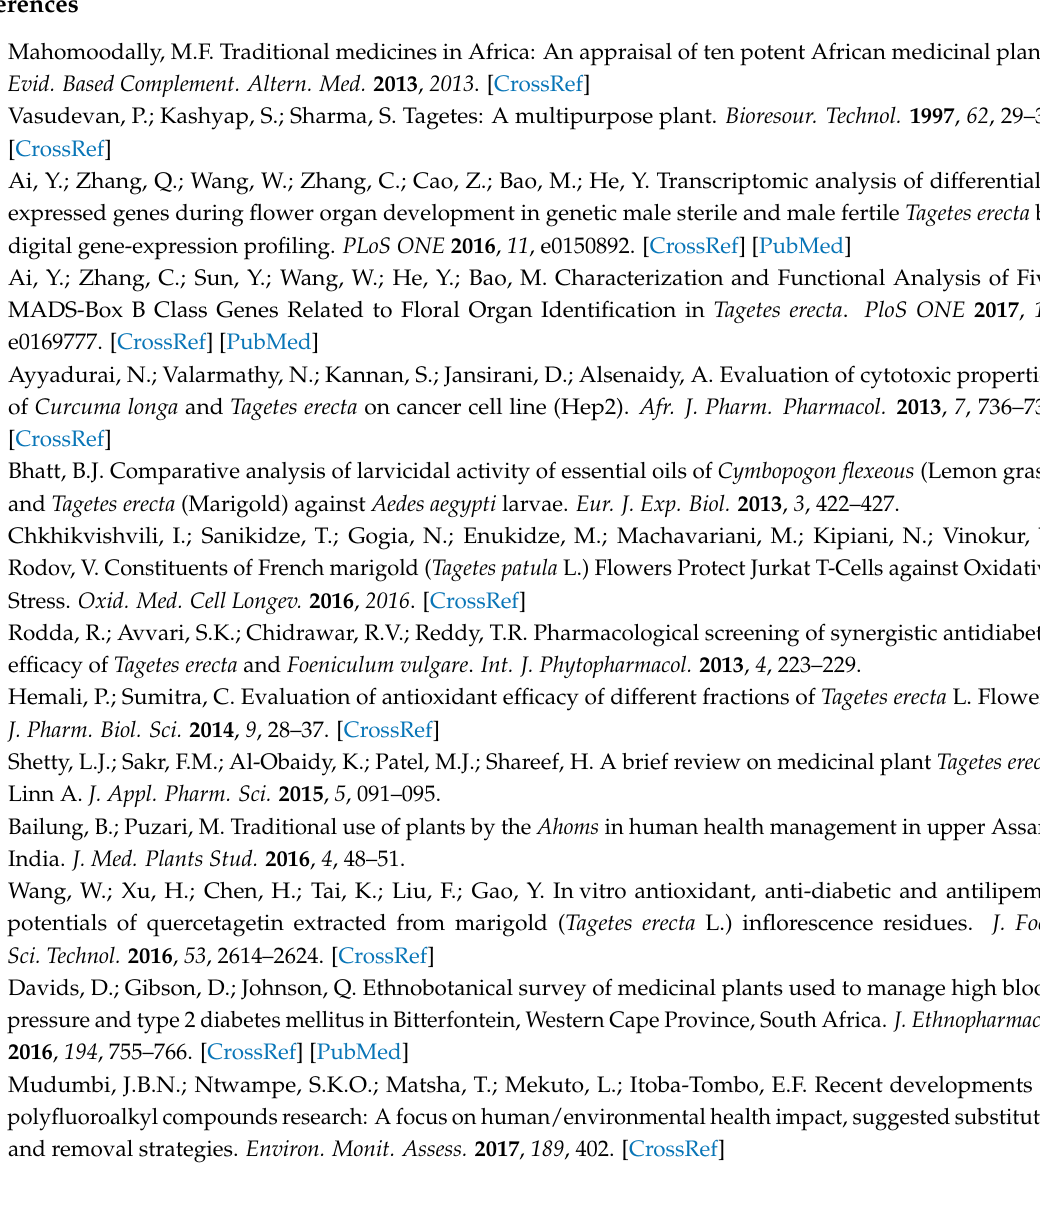
Table S1: Selected medicinal plants under possible threats by PFASs in South